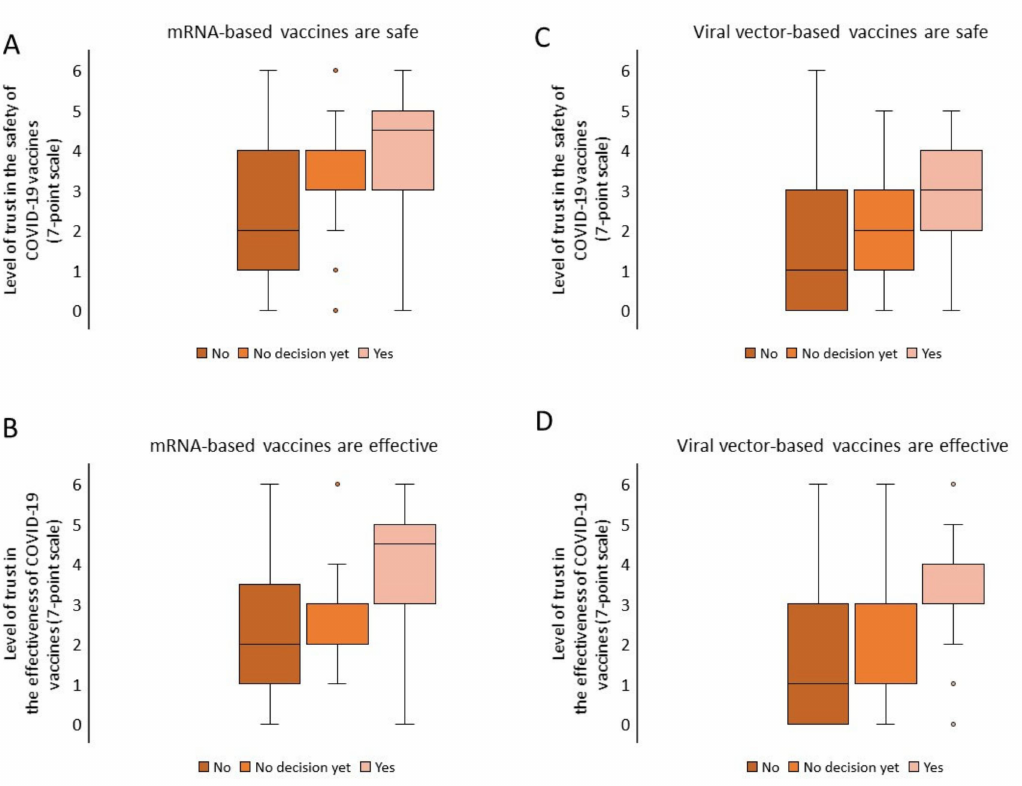
Figure 1. Perception of the safety and efficacy of COVID-19 vaccines in groups with different levels of willingness to be vaccinated. Analysis of the mean level of trust in groups with different levels of willingness to be vaccinated (ANOVA):